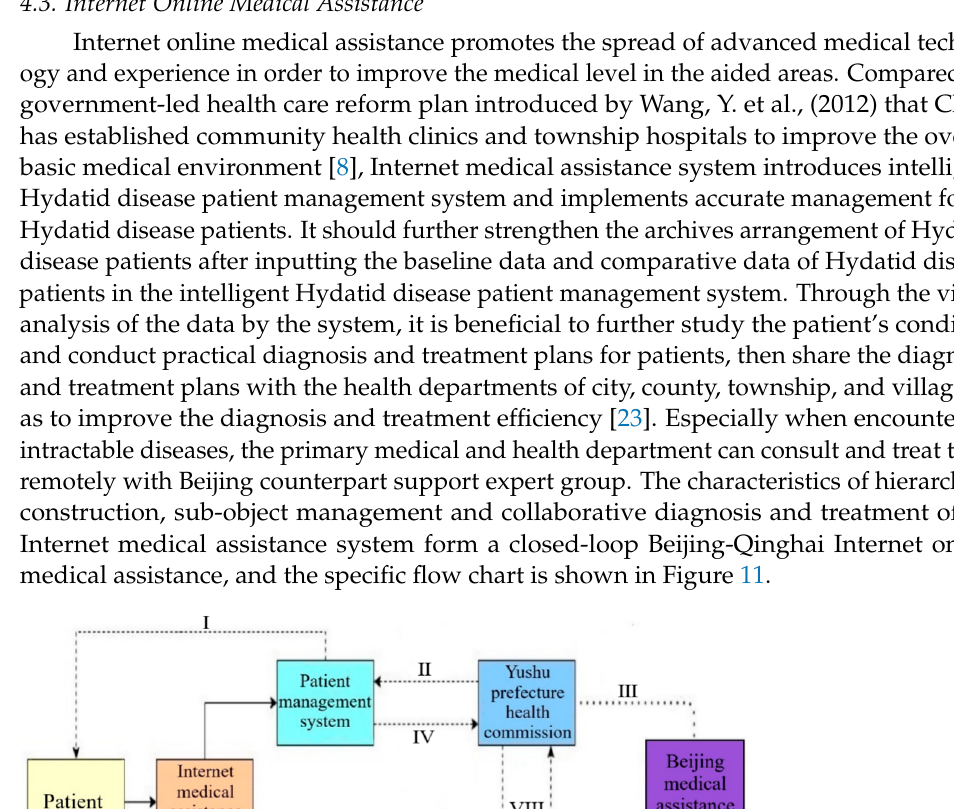
Figure 10. “1 village cadre + 1 medical staff + N patients” assistance pattern. Note: I Assign a filing list; II Summarize the latest health records of residents; III Summarize the latest condition of pa-